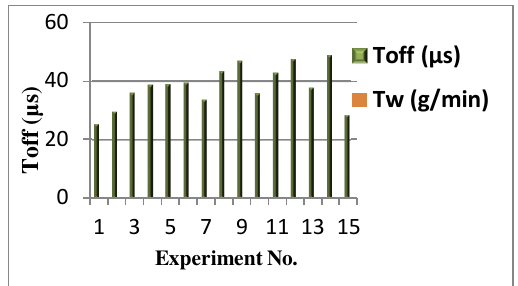
Fig. 7. Effect of pulse off time on